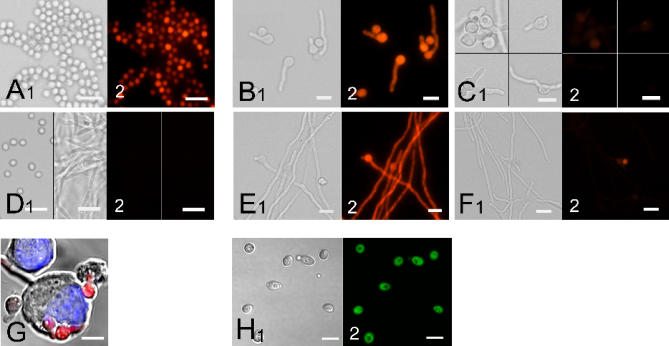
Fluorescence of A. fumigatus and C. albicans Strains Under Different Growth ConditionsA transgenic strain of A. fumigatus expressing DsRed2 under the control of the isocitrate lyase promoter (acuDp) was generated. To investigate the intensity of fluorescence as well as the dependency of the transgene expression on the carbon source, A. fumigatus was cultivated in AMM containing either glucose (A, C, and F) or ethanol (B, D, and E) as the sole carbon source. Different developmental stages were analyzed by light (panels 1) and fluorescence microscopy (panels 2). Resting conidia were derived from sporulating cultures on AMM agar plates containing glucose (A). Conidia were incubated in AMM for 7 h and 16 h to yield germlings (B and E) and hyphae (C and D), respectively. Identically treated wild-type conidia/hyphae are shown in (D). Fluorescence was observed irrespective of the carbon source in resting conidia. By contrast, germlings and hyphae only showed fluorescence when grown on ethanol. To test whether phagocytosis could activate the acuD promoter, we observed conidia germinating within macrophages 6 h after phagocytosis by J774 macrophages (G). An overlay is shown of the transmission light image, a DAPI stain for the nucleus (blue) and the red fluorescence of germinating conidia (G). To obtain green fluorescent C. albicans yeast cells, a number of cells were stained with the green cytoplasmic dye CFSE. A transmission light image (H1) and a fluorescence image (H2) of a fresh preparation of CFSE+
C. albicans yeast cells are shown. Bar = 5 μm.